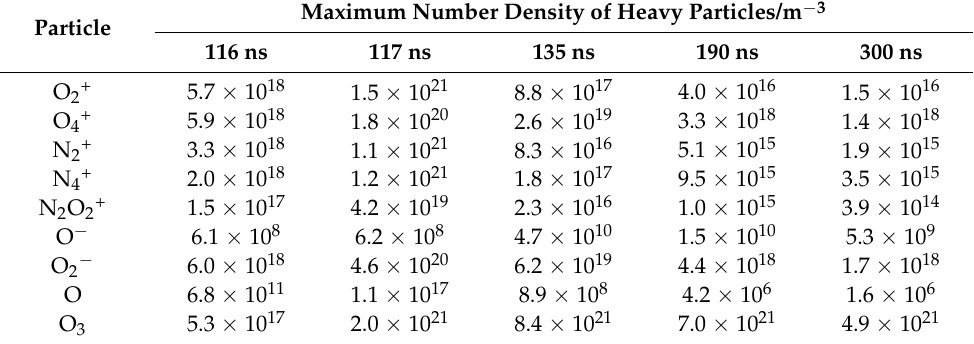
Table 3. The number density of heavy particles at different times.